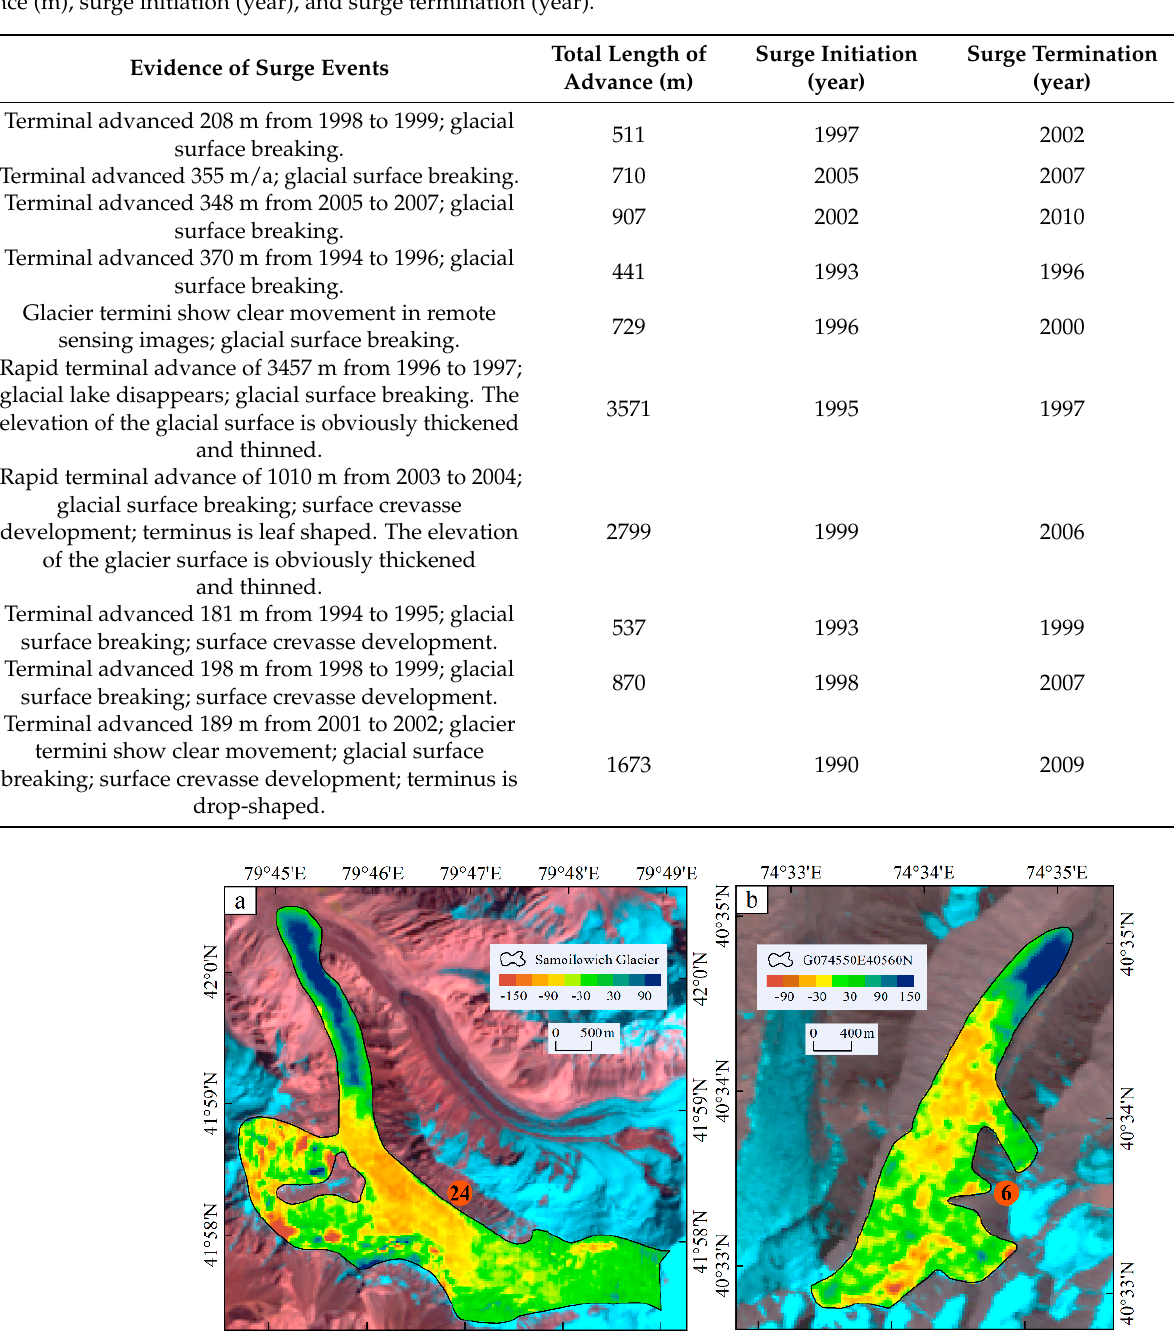
Figure 10. The figure shows ( a ) glacier thickness change (m) of glacier 24 from 2000 to 2007 and ( b ) glacier thickness change of glacier 6 from 2004 to 2011 (background: ( a , b ) Landsat Thematic Mapper (TM) image (Bands 5, 4, and 3); the images are LT51470311996222ISP00, and